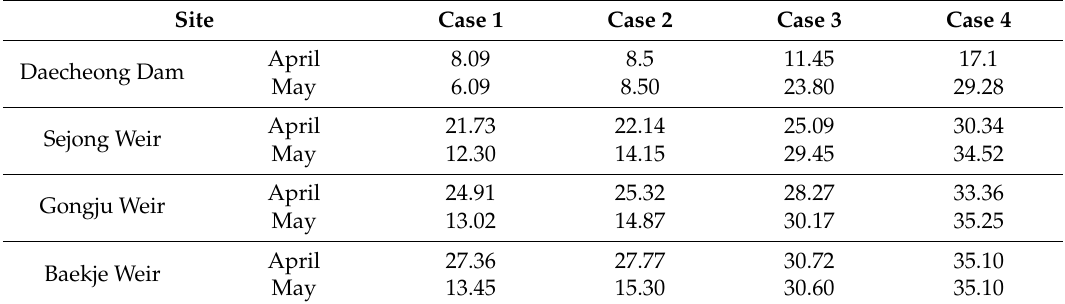
Table 7. Discharge volumes calculated for Gyuam point using HEC-ResSim (m 3 · s − 1 ). Site Case 1 Case 2 Case 3 Case 4